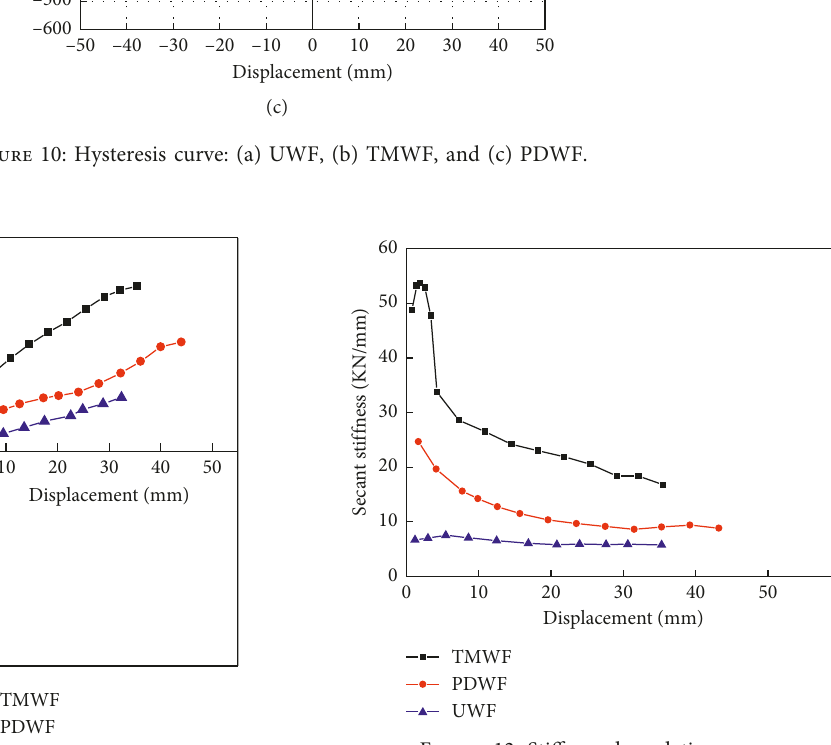
Figure 12: Stiffness degradation